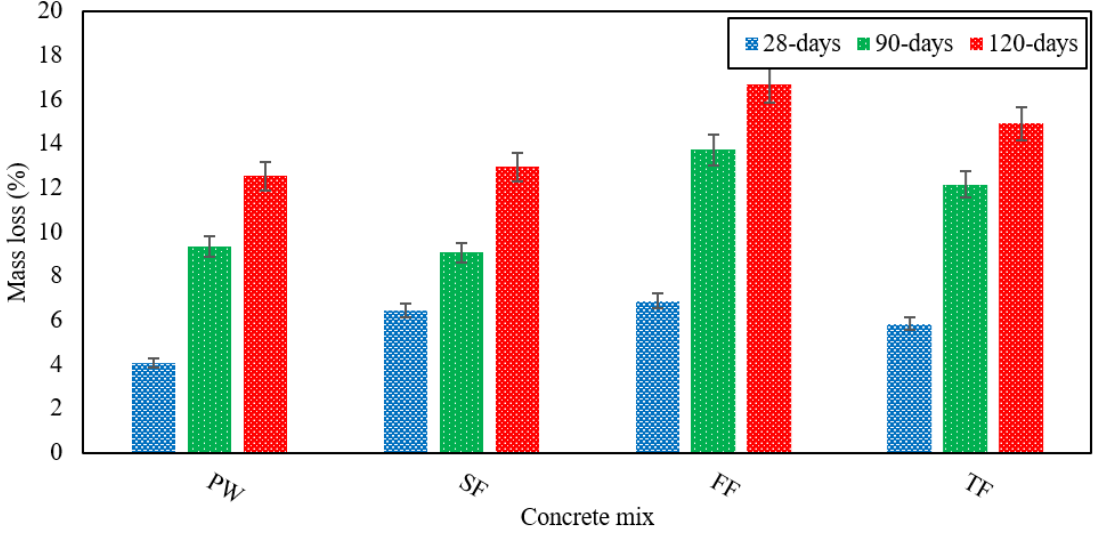
Figure 9. Mass loss of various RAGC mixes due to the attack of H 2 SO 4 at 28, 90, and 120 days of testing.